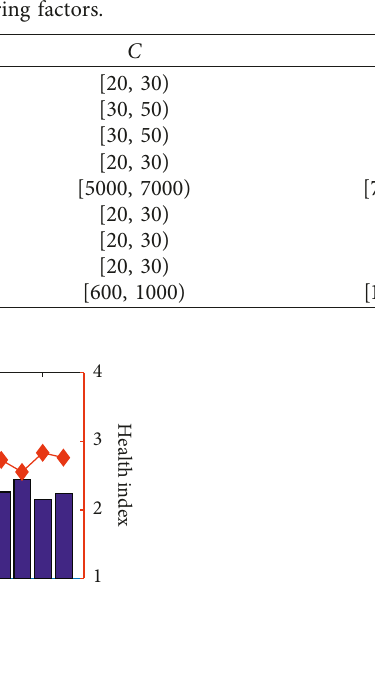
Figure 5: Horizontal displacement and health value of retained